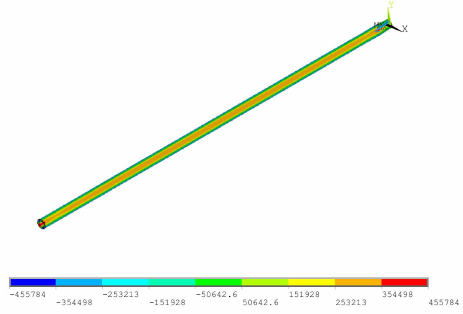
Figure 16. Shear stress